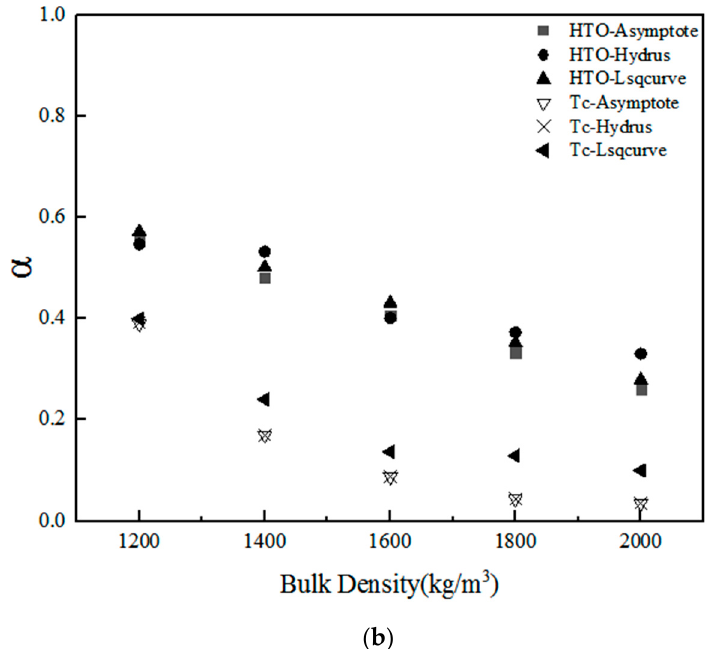
Figure 4. Different estimations of the diffusion parameters of HTO and Tc ( a ) apparent diffusion coefficient (Da); ( b ) capacity factor ( α ). Table 2. Results of the statistical analysis of the influence of different methods and different param- eters for HTO and Tc using p values.